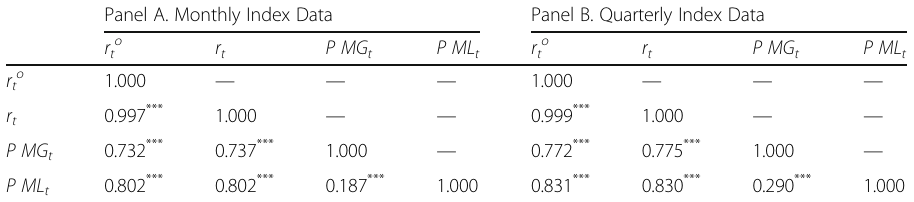
Table 2 Correlation Analysis on Stock Returns ( r t ), Stock Returns with Overnight Returns being included ( r to ), PMG t and PML